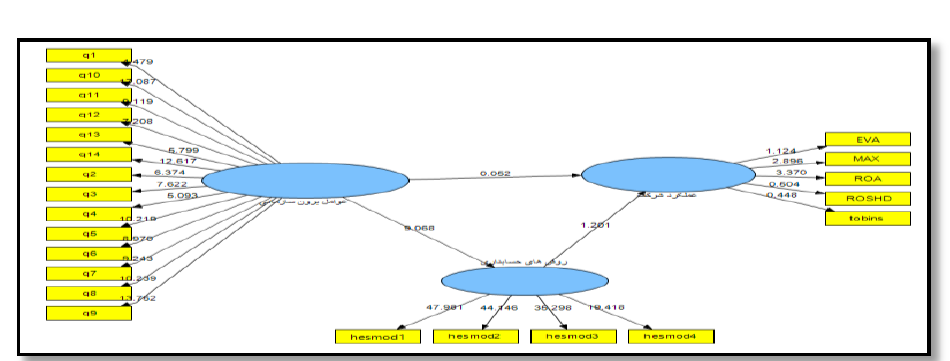
Figure 4. t-statistic for studying the significance of path coefficient